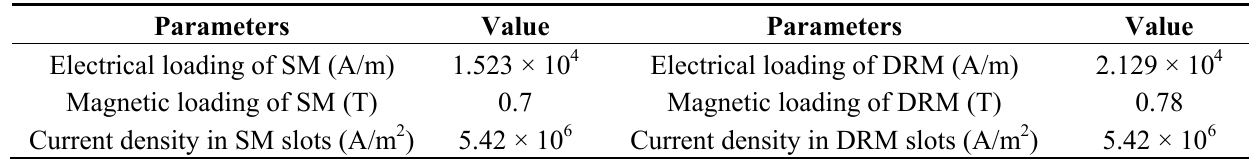
Table 2. Main parameters under CS-PMSM rated load condition.